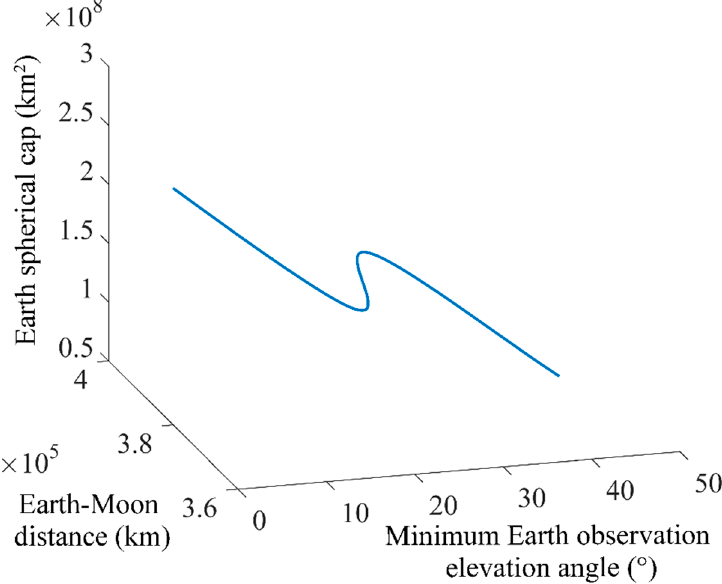
Figure 5. Dependence of the Earth spherical cap area on the Earth–Moon distance and minimum Earth observation elevation angle.